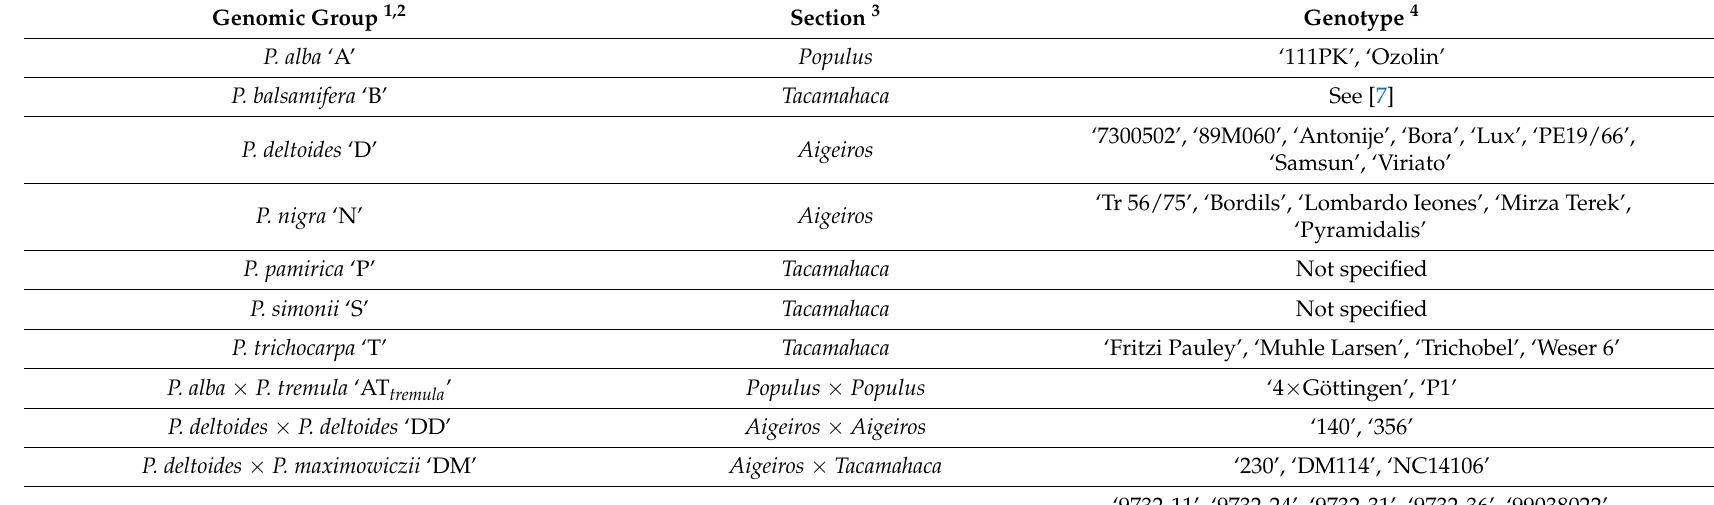
Table 2. Genomic groups, taxonomic sections, and genotypes of Populus , Robinia , and Salix tested worldwide and described in the contributions of the Special Issue on the Growth and Development of Short-Rotation Woody Crops for Rural and Urban Applications (https://www.mdpi.com/journal/forests/special_issues/ growth_development_woody_crops, accessed on 25 May